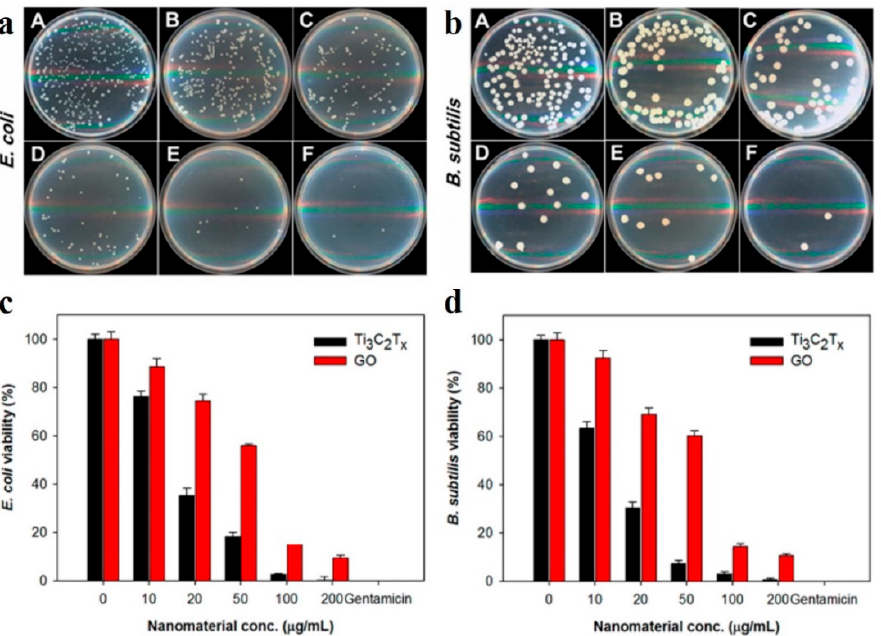
Figure 5. Ti 3 C 2 T x nanosheet membranes. ( a ) Antibacterial activities of Ti 3 C 2 T x membranes in an aqueous solution against E. coli and ( b ) B. subtilis with different concentrations, i.e., 0 µ g/mL ( A ), 10 µ g/mL ( B ), 20 µ g/mL ( C ), 50 µ g/mL ( D ), 100 µ g/mL ( E ), and 200 µ g/mL ( F ), respectively. ( c , d ) Cell viability measurement and comparison studies of Ti 3 C 2 T x and GO membranes against E. coli and B. subtilis bacterial strains. Bacterial suspensions (107 CFU/mL) were incubated with different concentrations (0–200 µ g/mL) of Ti 3 C 2 T x and GO membranes at 35 ◦ C for 4 h at a speed of 150 rmp. Reprinted with permission from [97]. Copyright 2016 American Chemical Society. Table 1. MXene-based membranes for the separation of ions, molecules, and pathogens from water. Type of Membrane Fabrication Method Feed Solution/Concentration Rejection (%)